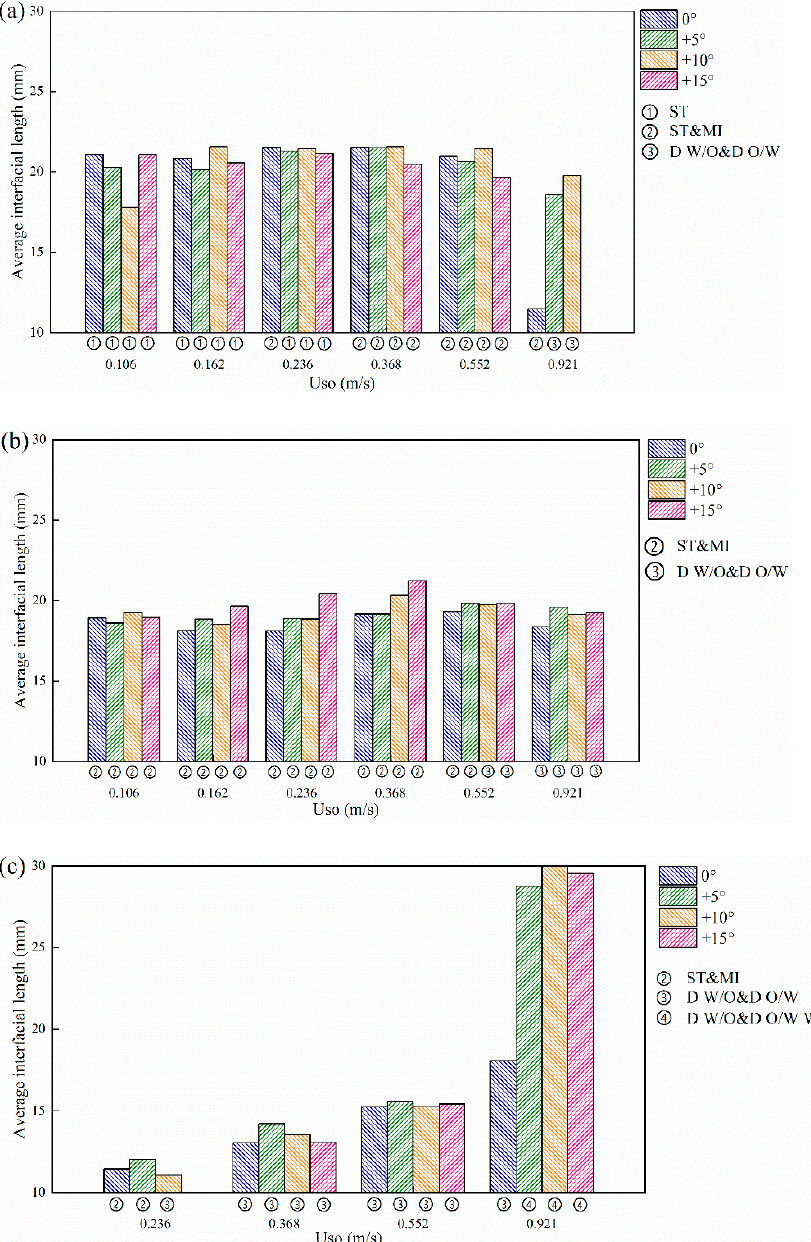
Figure 23. Average interfacial length at different pipe inclinations: ( a ) U sw = 0.184 m/s; ( b ) U sw = 0.368 m/s; ( c ) U sw = 0.737 m/s.